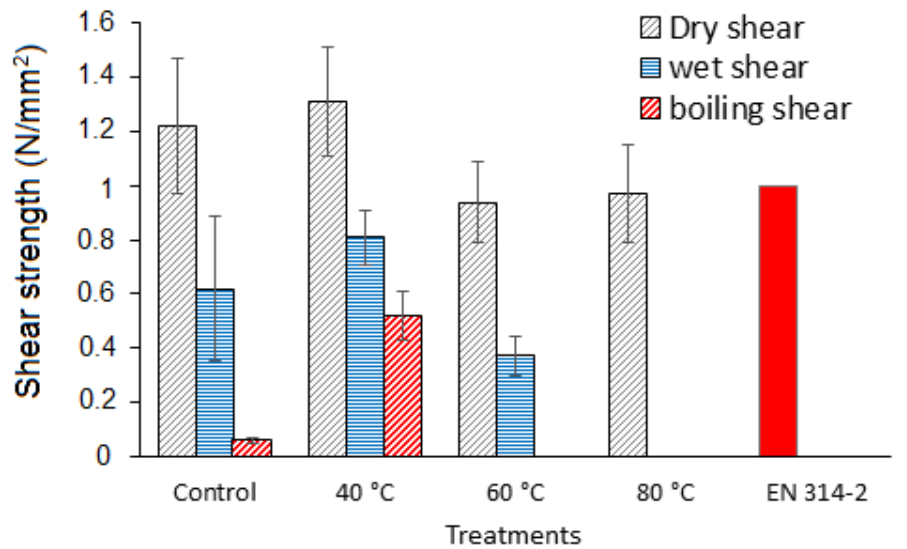
Figure 1. Effect of pre-heating treatment (40, 60, and 80 °C) on shear strength of plywood specimens in different conditions (dry, cold water soaking, and boiling water soaking). * Control: Ambient temperature (20 ± 2).** EN 314-2 specifies 1 N/mm 2 for dry shear strength of plywood [32].